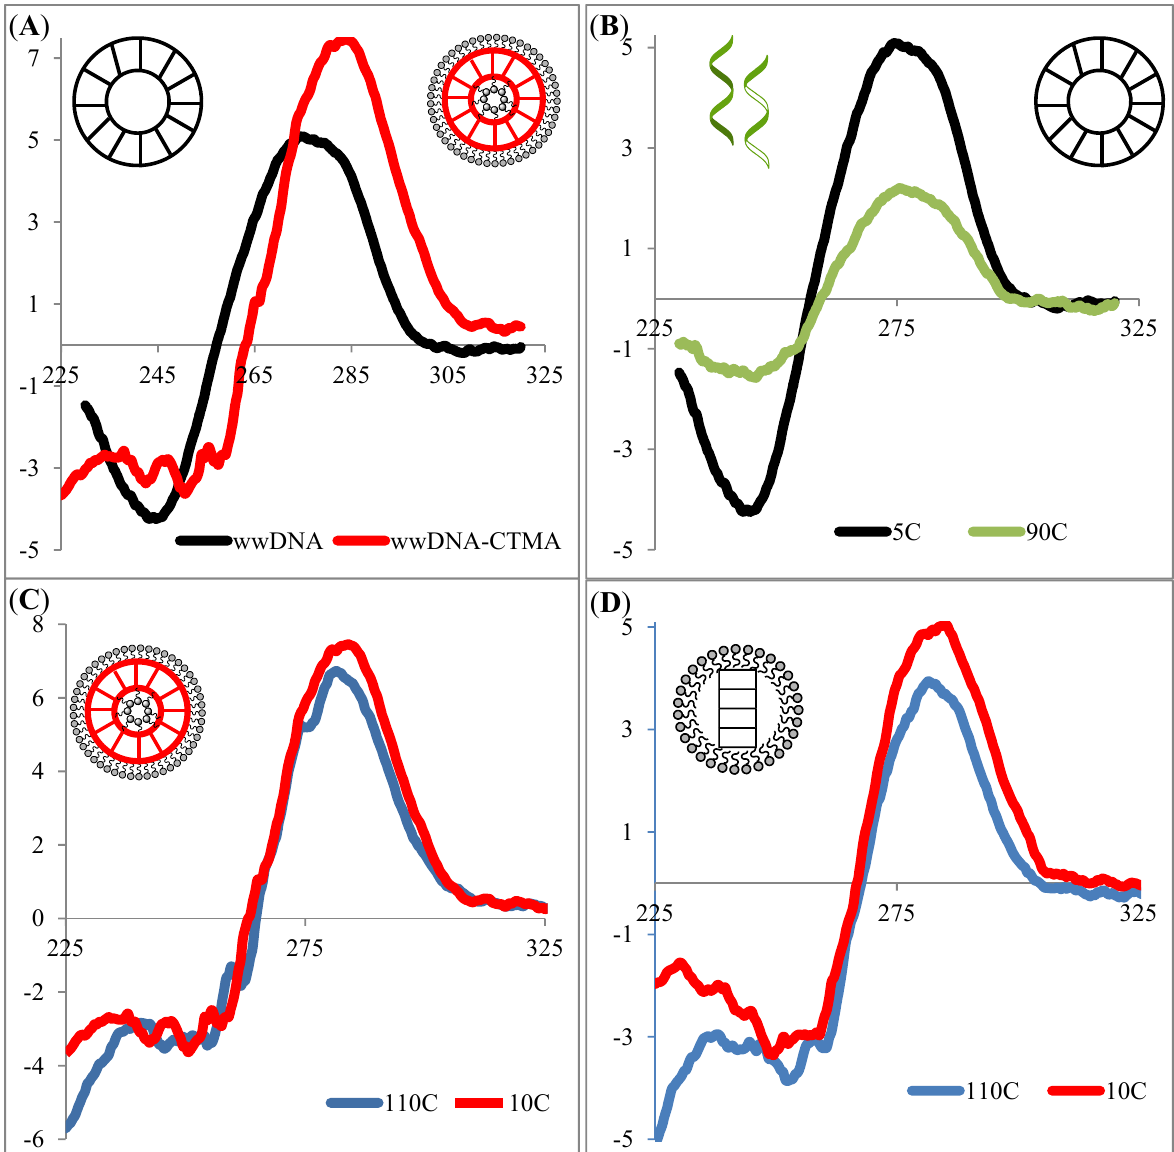
Figure 3. CD Spectroscopy ( A ) wwDNA sample in aqueous solution (black) vs. wwDNA-hexadecyltrimethylammonium (wwDNA-CTMA) complex in butanol (red) at 10 °C; ( B ) wwDNA in aqueous solution at 5 °C (black) vs. 90 °C (green); ( C ) wwDNA-CTMA in butanol at 10 °C (red) vs. 110 °C (blue); ( D ) Ladder DNA-CTMA in butanol at 10 °C (red) vs. 110 °C